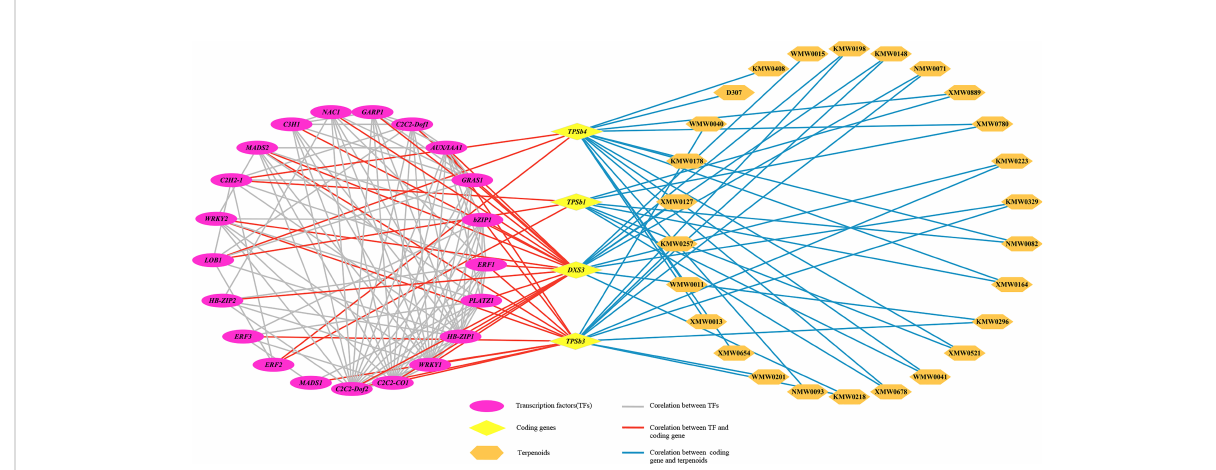
FIGURE 9 The transcriptional metabolic regulatory network consisting of terpene synthesis-related genes, candidate transcription factors and terpenoids volatile metabolites. Purple ovals represented transcription factors, yellow diamonds represented coding genes, and orange hexagons represented terpenoids. The gray line represented correlation between transcription factors, the red line represented correlation between coding gene and transcription factor, and the blue line represented Correlation line between coding gene and